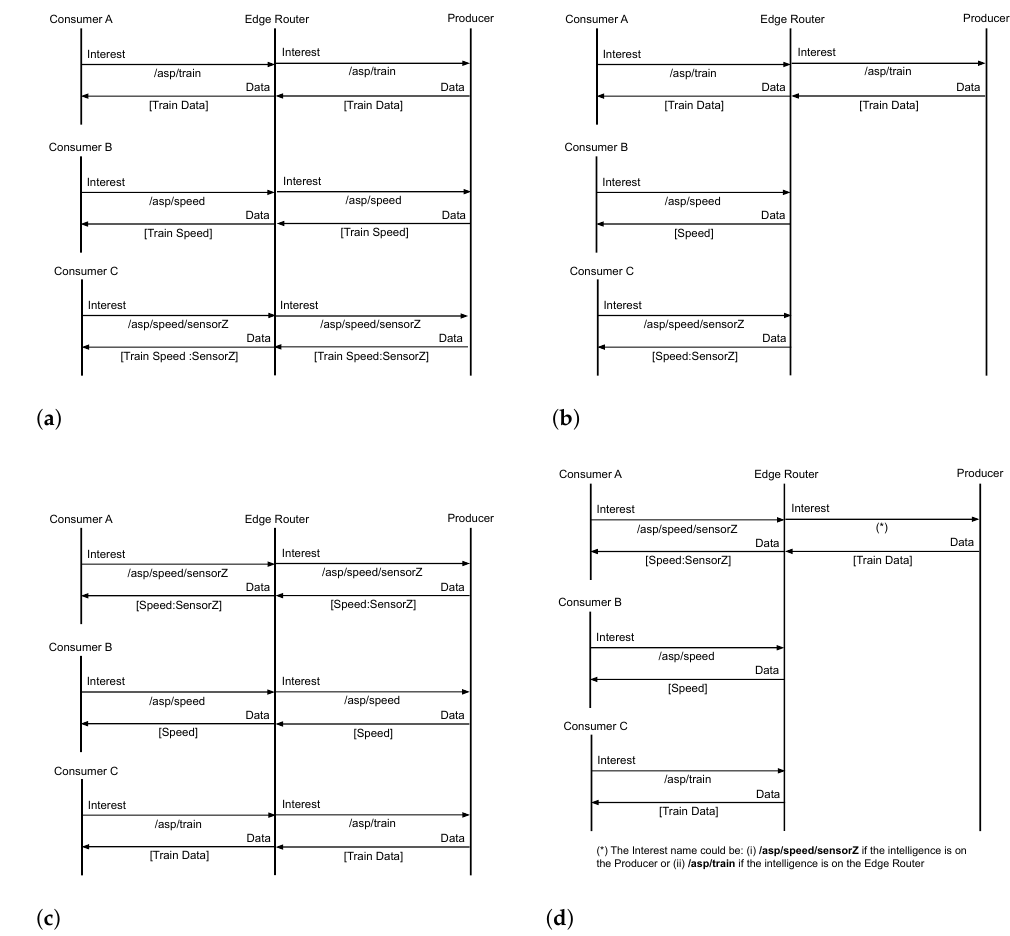
Figure 3. NDN strategies for selective content retrieval: ( a ) Simple Request; ( b ) Advanced Request; ( c ) Simple Response; ( d ) Advance